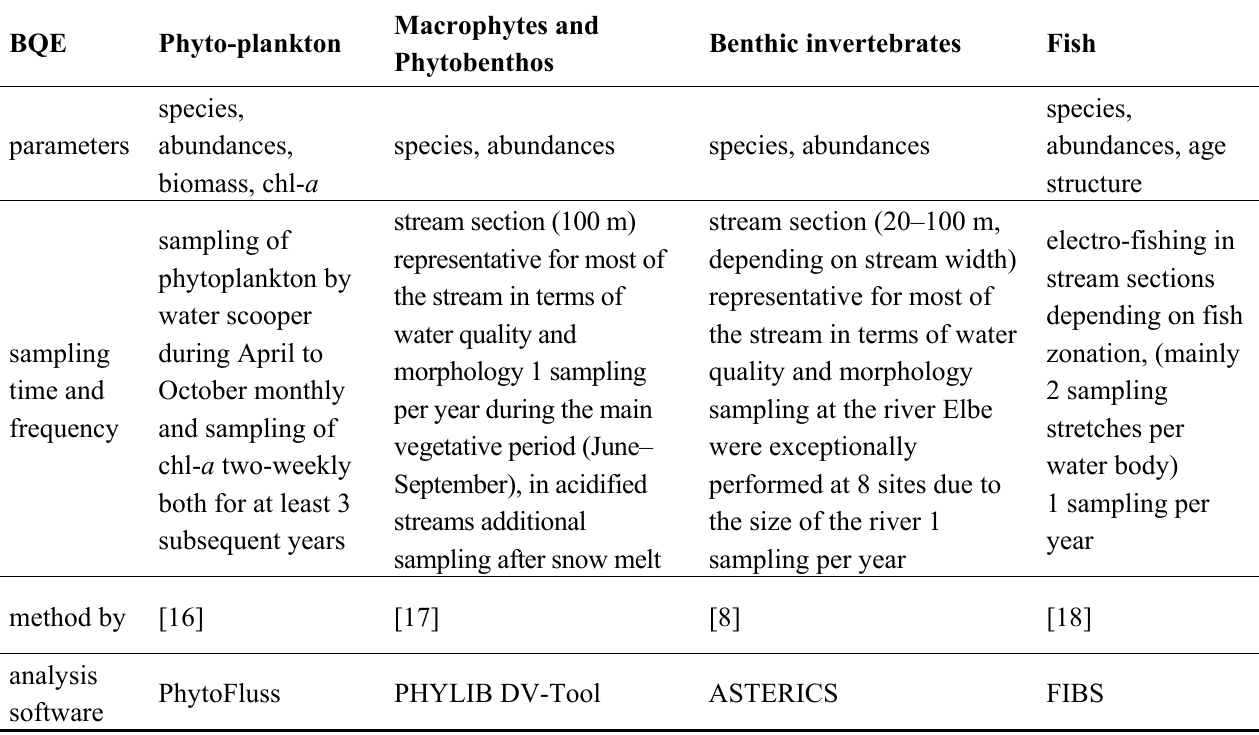
Table 2. Assessment methods for classification of the ecological status of streams by biological quality elements